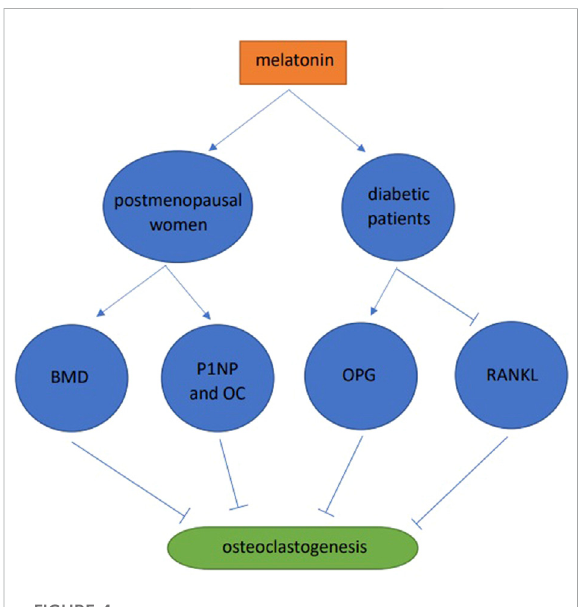
FIGURE 4 Human studies of melatonin and osteoclast differentiation.